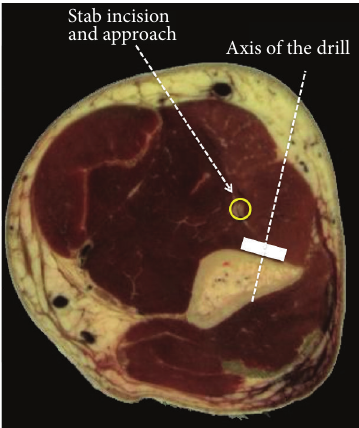
Figure 4: Cross section of the left arm of an adult woman (visible woman server, EPFL, Switzerland) demonstrates the relationship betweenthestabincisionabovetheantecubitalfold,theradialnerve, and the plate on the anterolateral aspect of the distal humerus. The radial nerve (yellow circle) is embedded between the brachialis and brachioradialis muscles, in a line connecting the stab incision above the antecubital fold and the